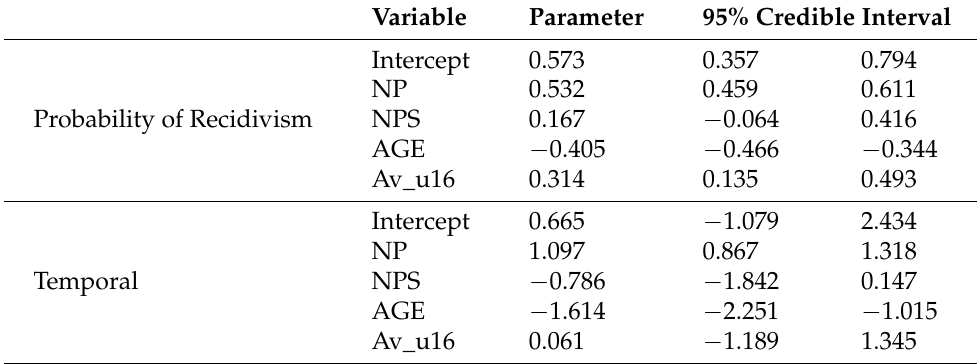
Table 1. Estimation of the probability and temporal components of recidivism in the cure rate model.